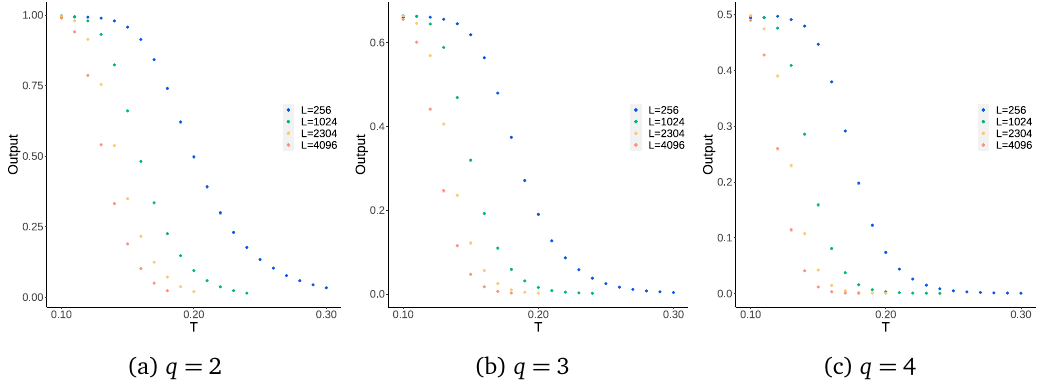
Figure 9: The relationship between temperature and the average output of an ensem- ble of 10 independently trained ANNs – training with MC data of the ferromagnetic square-lattice Ising model, and testing with MC data of the one-dimensional ferro- magnetic q -state Potts model. The error bars shown are 99.7% confidence intervals of the ensemble